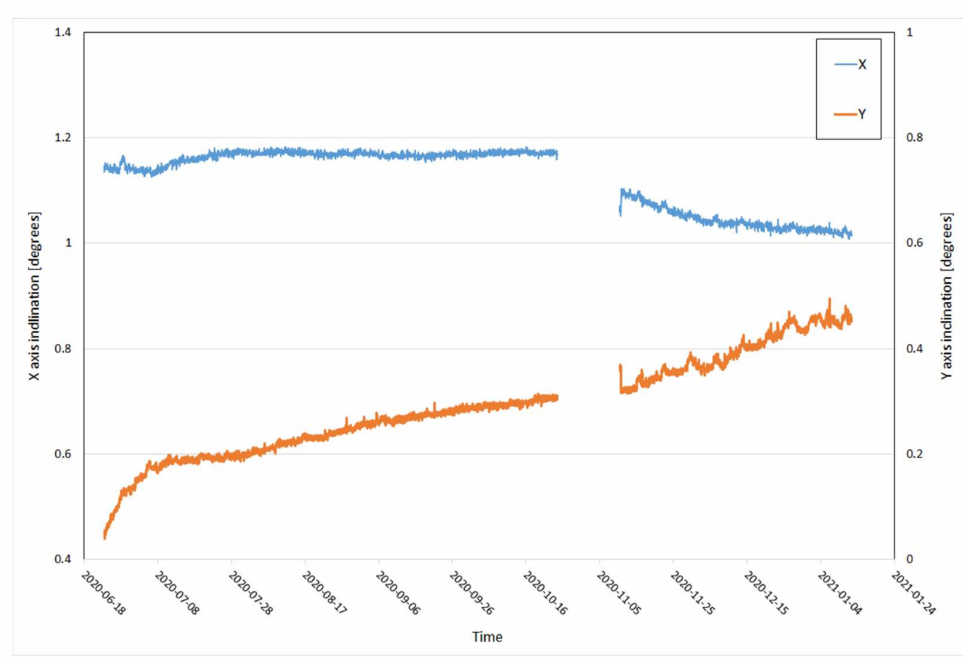
Figure 12. Changes in the slope (X and Y components) recorded by the CNS 225 sensor in the SI-XI/4 panel.